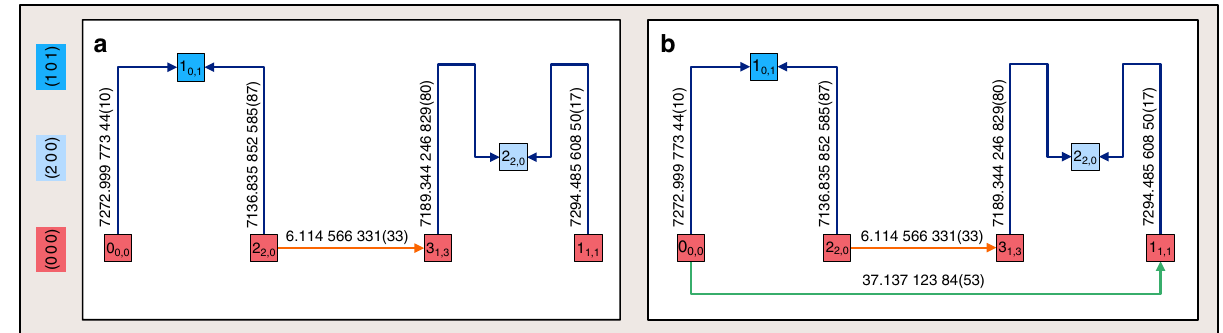
Fig. 5 Application of the generalized Ritz principle to the (0 0 0)1 1,1 state. a , b show a path ( P ) and a cycle ( C ) involving the (0 0 0)1 1,1 level, respectively. The J K rotational labels 70 are indicated for each rovibrational state, while the canonical ( v 1 v 2 v 3 ) vibrational assignments 69 are marked in the left-side a ; K c color legend. Transitions with blue arrows are results of the present NICE-OHMS experiments, while those with orange and green colors are taken from refs. 37,49 , respectively. Each line is connected with its wavenumber (in cm − 1 ) and the uncertainty of the last few wavenumber digits is within parentheses. Successive application of the Ritz principle leads to a the best estimate of the (0 0 0)1 1,1 energy value, 37.137 125 52(23) cm − 1 , derived from P , and b the discrepancy of C , supplied with an uncertainty, 1.68(58) × 10 − 6 cm − 1 (see cases III – IV of Fig. 1). The energies of the internal states [(1 0 1)1 0,1 , (0 0 0)2 2,0 , (0 0 0)3 1,3 , and (2 0 0)2 2,0 ] can be similarly obtained from P . Accepting the line uncertainties of P , the relatively large discrepancy of C indicates that the (0 0 0)1 1,1 energy can be more accurately calculated from P than from the direct link taken from ref. 49 . Source data are provided as a Source Data fi